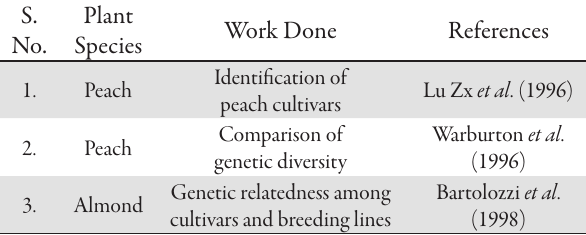
Tab. 3. Successful examples of RAPD techniques in fruit